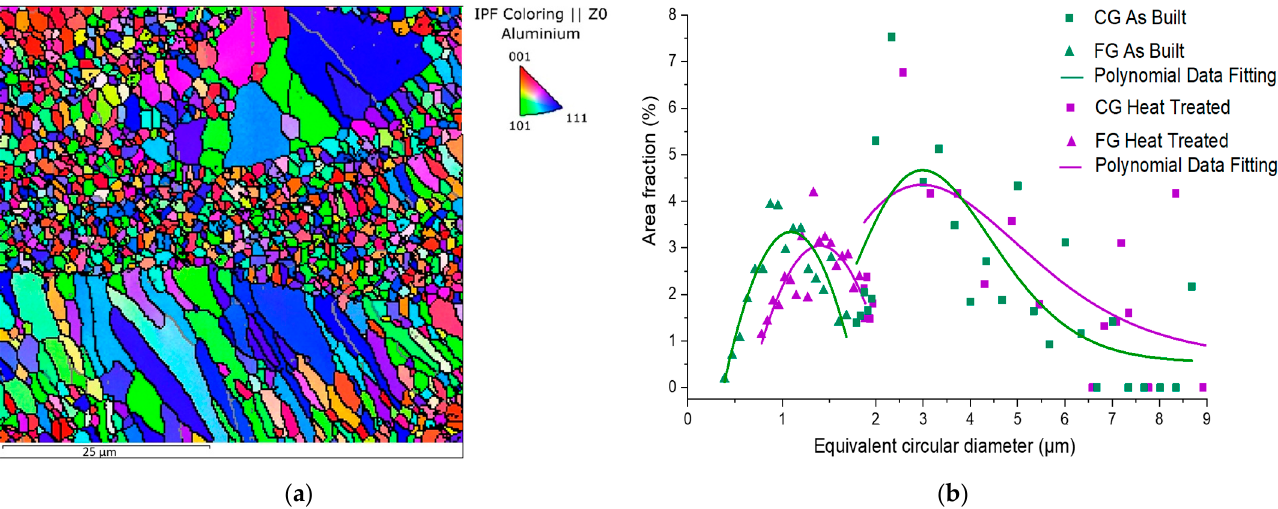
Figure 8. The EBSD orientation map of heat-treated sample ( a ) and grain size distribution before and after heat treatment ( b ).